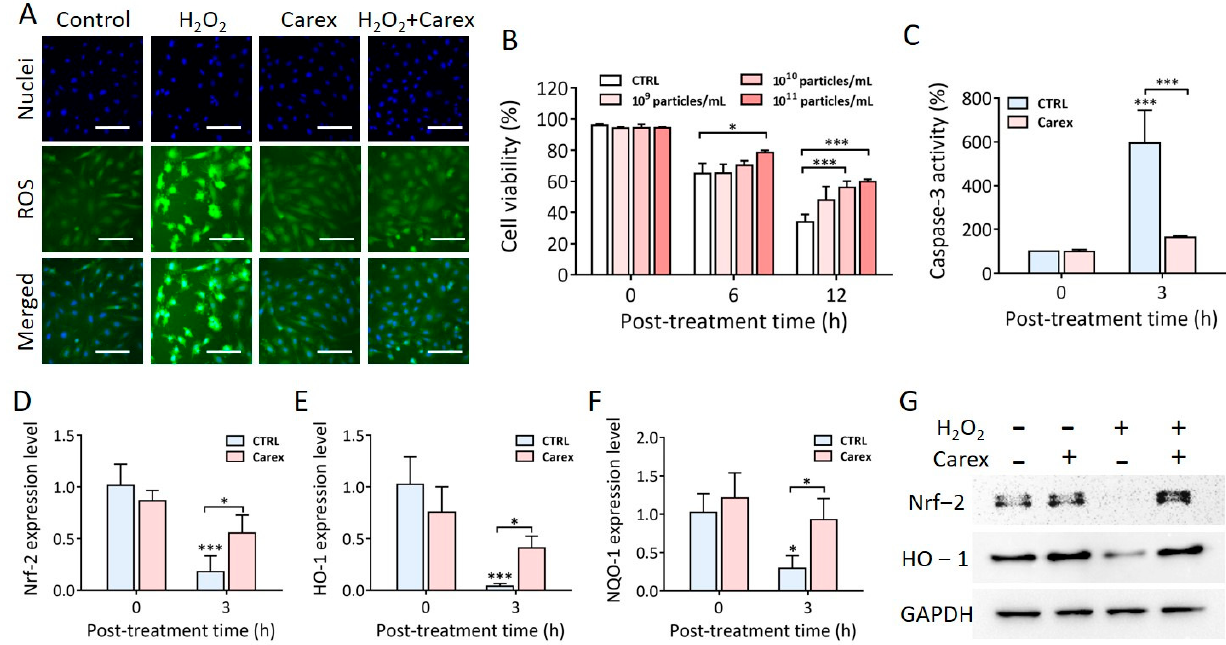
Figure 4. Antioxidative and apoptotic effect of Carex in H9C2 cardiomyoblasts. ( A ) Cells were supplemented with 1 × 10 11 particles/mL of Carex by oxidative stress induction, using H 2 O 2 . The intracellular ROS levels (green) and nuclei (blue) were stained using H2DCFDA and Hoechst 33342, respectively, followed by fluorescence microscopic observation. The scale bars indicate 100 μ m. ( B ) Cells were supplemented with different concentrations of Carex for 1 d followed by H 2 O 2 treatment. Cell viability was measured by a WST-1 assay. ( C ) Caspase-3 inhibition in H9C2 cells by Carex. ( D – F ) RT-PCR analysis of Nrf-2 ( D ), HO-1 ( E ), and NQO-1 ( F ) mRNA expression levels. ( G ) Western blot analysis of Nrf-2 and HO-1 protein expression levels. GAPDH was used as an internal control. All values are expressed as mean ± SD (* p < 0.05, *** p < 0.001; n = 3).